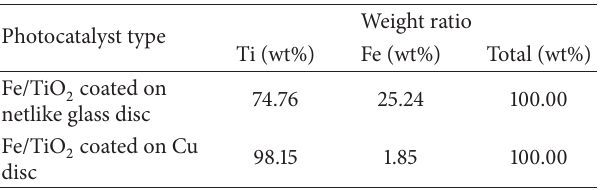
Table 1: Weight ratio of elements Fe and Ti within prepared metal doped TiO 2